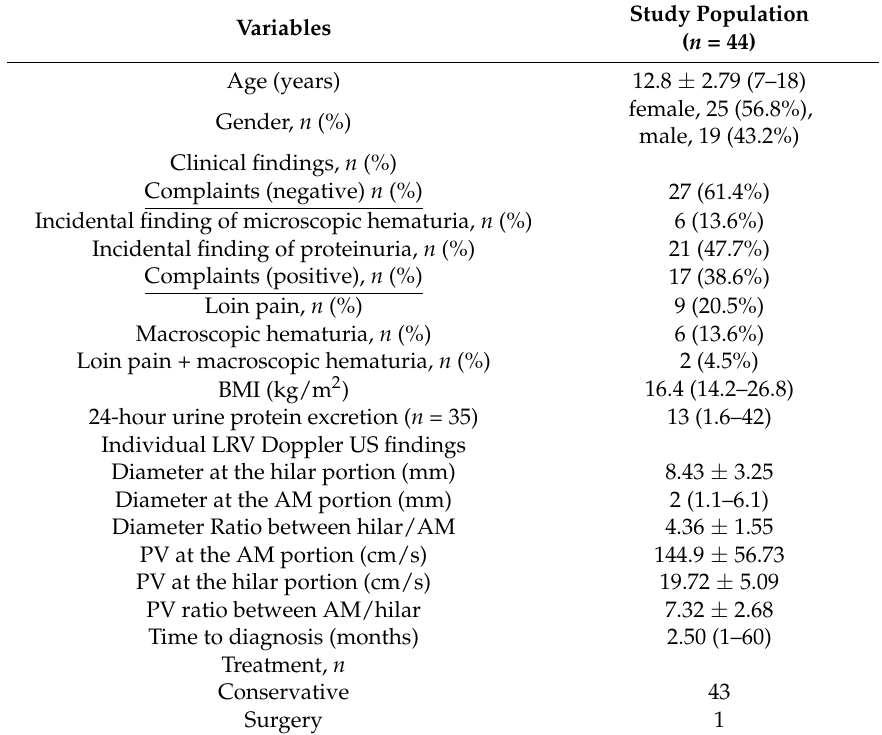
Table 1. Baseline clinical characteristics and left renal vein (LRV) Doppler ultrasonography (DUS) findings of the study cohort.